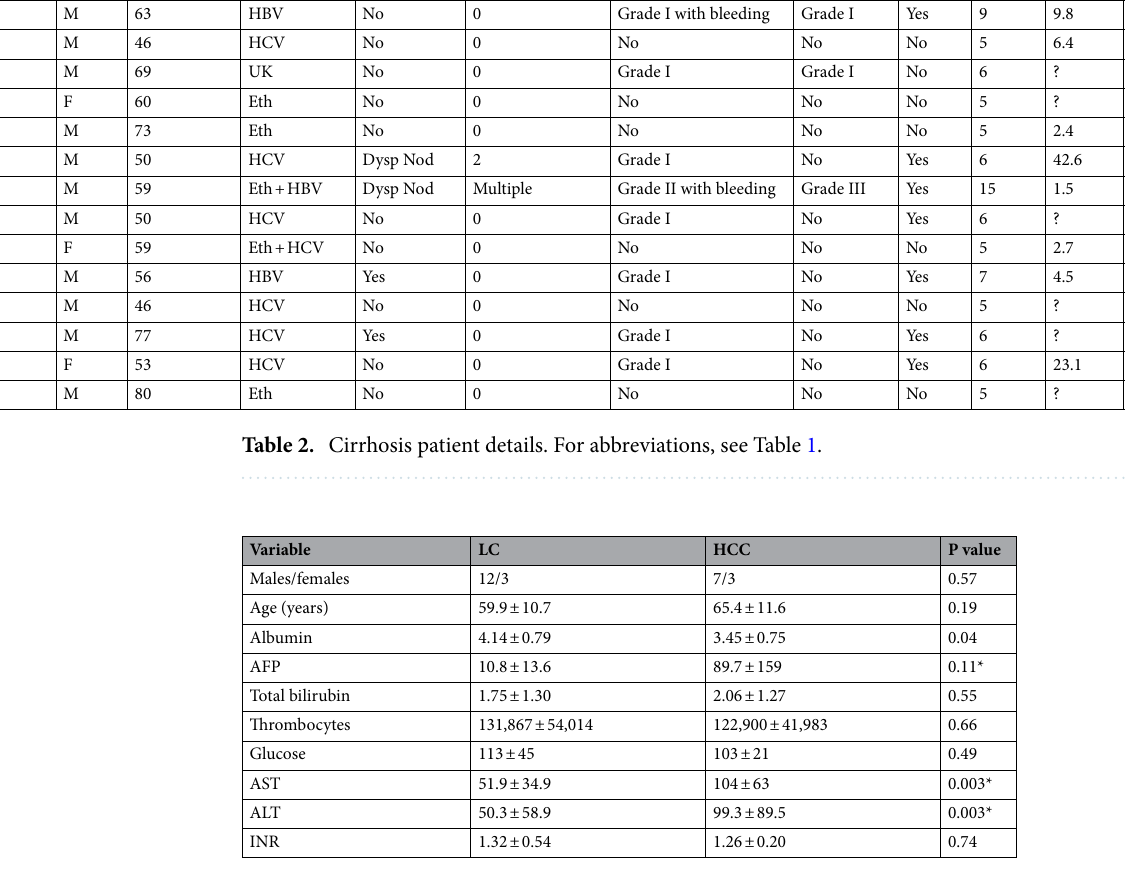
Table 3. Comparison of clinical variables for liver cirrhosis (LC) and hepatocellular carcinoma (HCC) patients. For continuous variables, mean ± standard deviation is given with comparisons made using unpaired t tests. For categorical variables, comparisons were made using the chi-squared test. *Analyzed by nonparametric Mann Whitney U test due to non-Gaussian distribution of